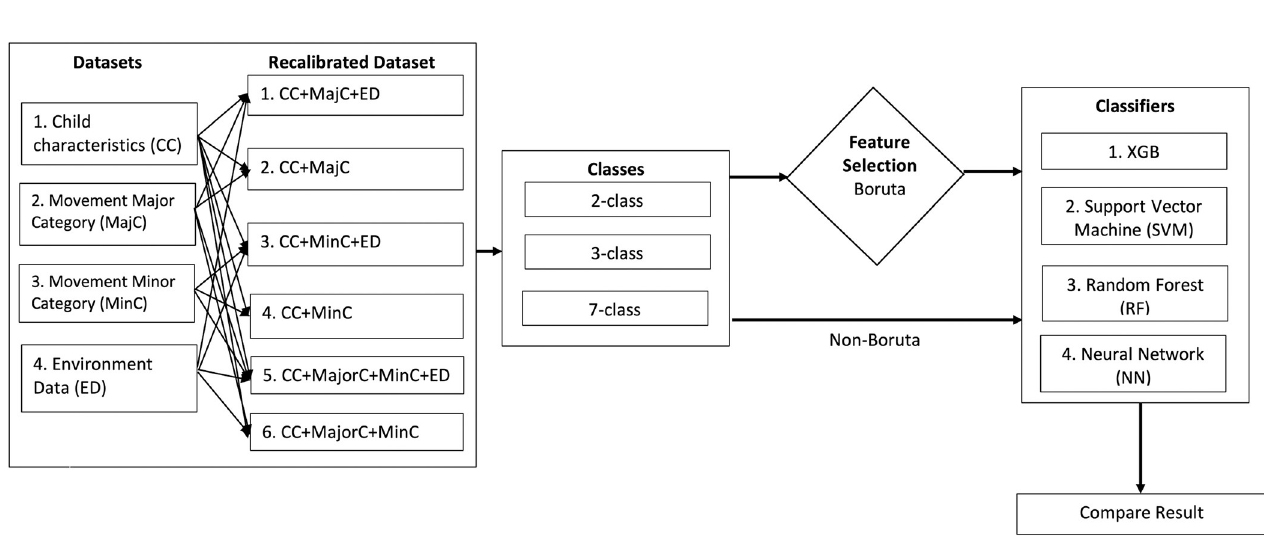
Fig 2. Data analyses workflow from dataset combination to classification accuracy comparison.